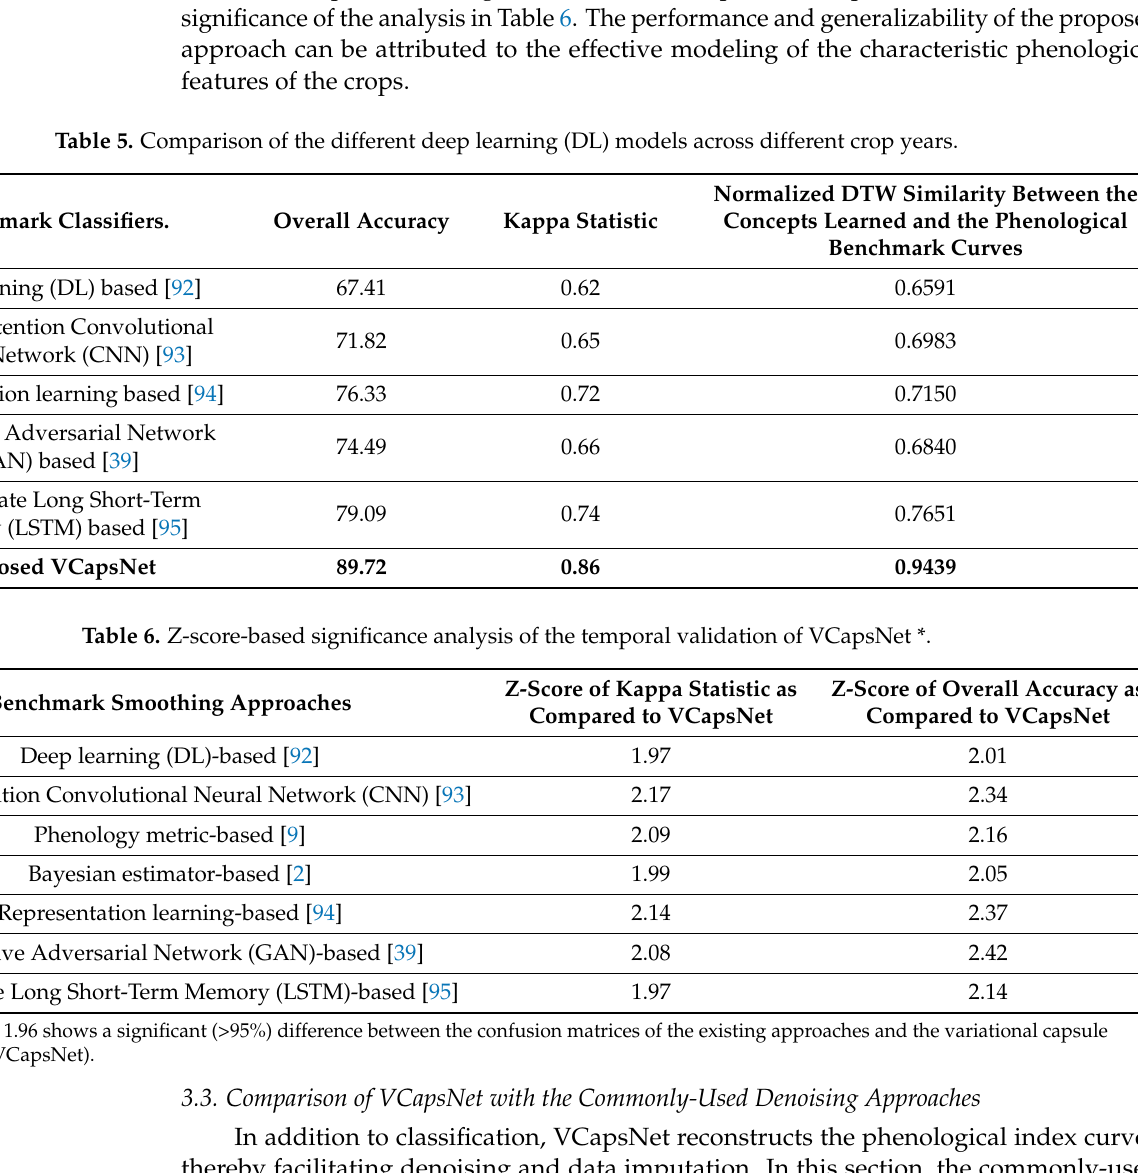
Table 5. Comparison of the different deep learning (DL) models across different crop years.